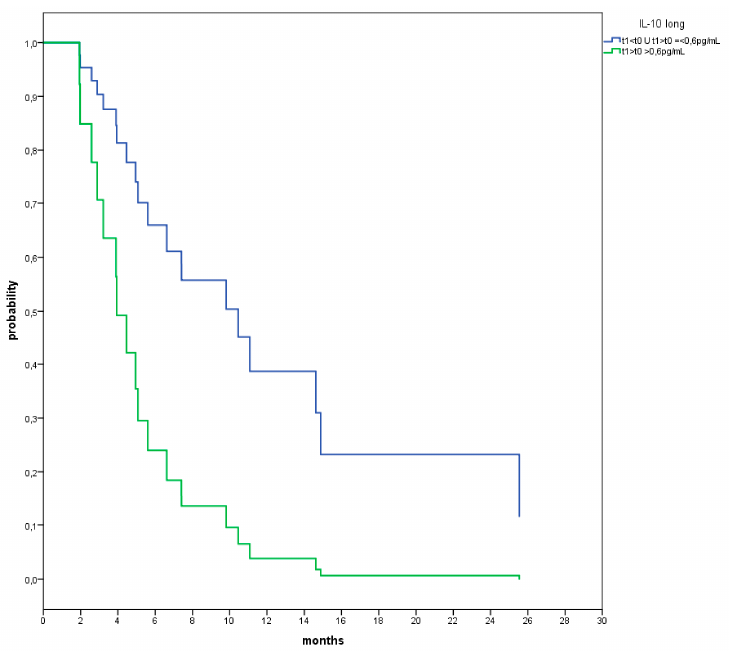
Figure 9. Cox analysis for OS between pts (blue line) which show IL-10 values at t1 lower than t0 (t1 < t0) or lower than a cut-off value of increment defined by ROC analysis (0.6 pg/mL) and pts (green line) which show an increment above the cut-off value (0.6 pg/mL) at t1 compared to at t0. (HR: 0.291; 95% CI: 0.103–0.822; p = 0.020).